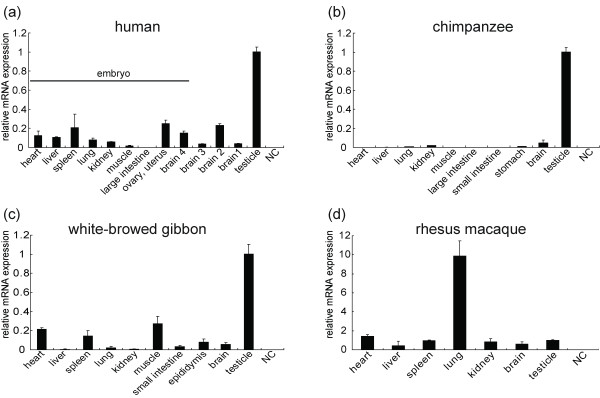
The expression patterns of RHOXF2 determined by qPCR in humans(a), chimpanzee(b), white-browed gibbon(c) and rhesus macaque(d). The relative expression levels were calculated by setting the expression level in testicle as "1". For the human samples, Brain 1(40 yrs), Brain 2 (28 yrs), Brain 3 (newborn, 1 month) and testicle (76 yrs) are all male individuals. The human embryo is a 36-weeks female. The ages of the nonhuman primate samples are 2 yrs for the male chimpanzee, 6 yrs for the male white-browed gibbon and 20 yrs for the male rhesus macaque. "NC" refers to negative control. The detailed sample information of the nonhuman primate species is described in Materials and Methods.